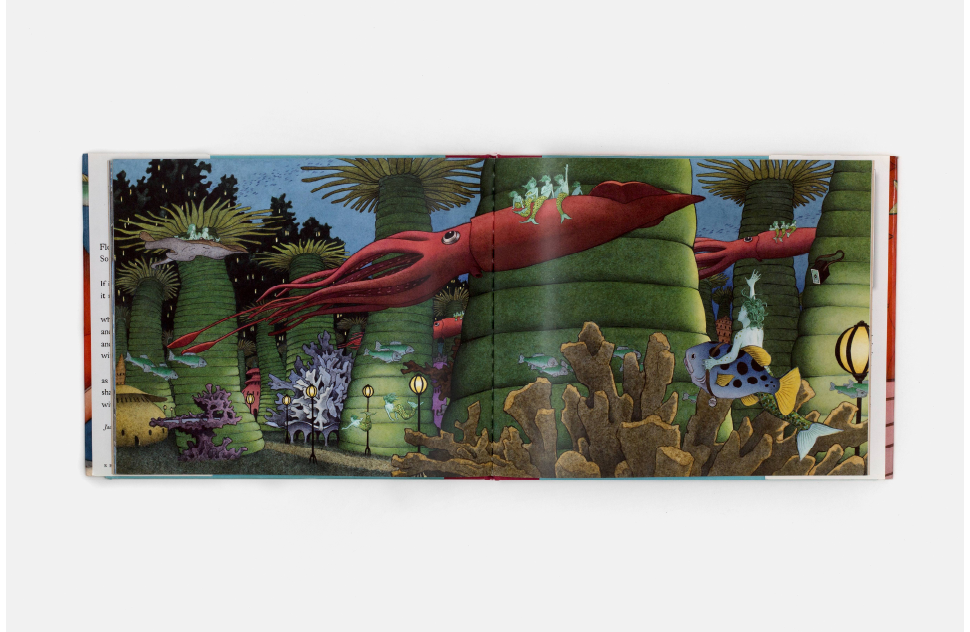
Figure 3. Wiesner D. (2006), Flotsam, Clarion Books, New